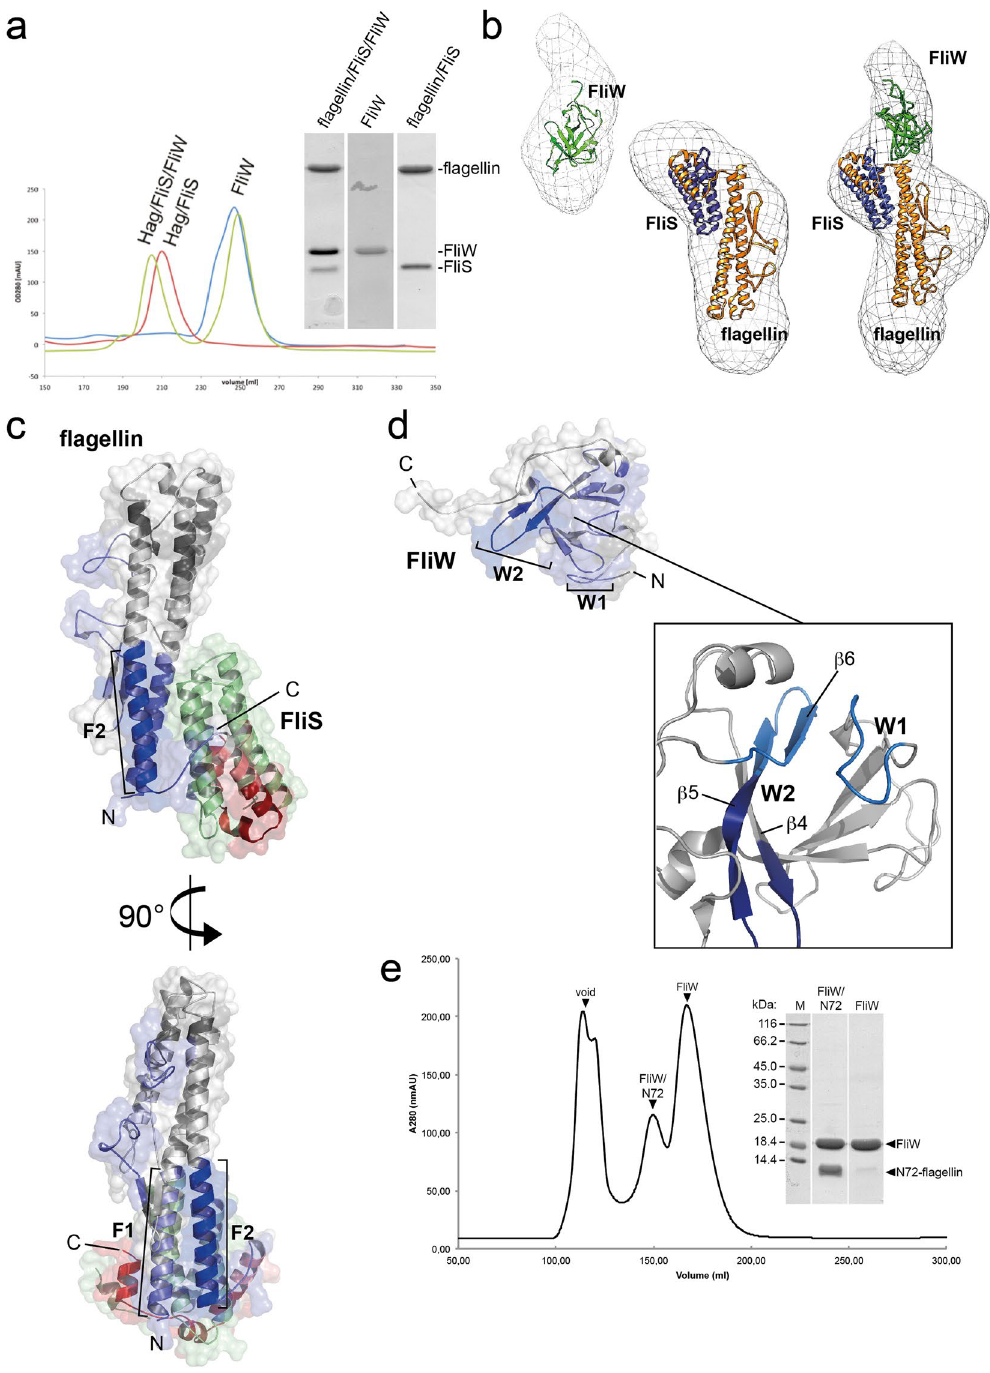
Figure 4. SAXS- and HDX-analysis of the FliS/flagellin/FliW interaction. ( a ) Size-exclusion chromatograms (SEC) of flagellin/FliS (red), FliW (blue) and FliS/flagellin/FliW (green). The inset shows a Coomasse-stained SDS PAGE of the peak fractions. ( b ) SAXS analysis of FliW, flagellin/FliS and FliS/flagellin/FliW. The crystal structures have been fitted to the SAXS-density with the docking algorithm implemented in Chimera. ( c ) HDX analysis of flagellin/FliS versus flagellin/FliW. The difference in HDX-labelling is shown from blue (less exchange) to red (more exchange) in Dalton. Blue regions in the cartoon representation of flagellin/FliS exchange less in the presence of FliW (F1 and F2), whereas red regions get unprotected. ( d ) HDX analysis of FliW versus flagellin/FliW. The difference in HDX-labelling is shown from blue (less exchange) to red (more exchange) in Dalton. Blue regions in the cartoon representation of FliW exchange less in the presence of flagellin (W1 and W2). ( e ) SEC-chromatogram of a flagellin N72 /FliW complex ( left ) and a Coomassie-stained SDS-PAGE of the two peak fractions ( right